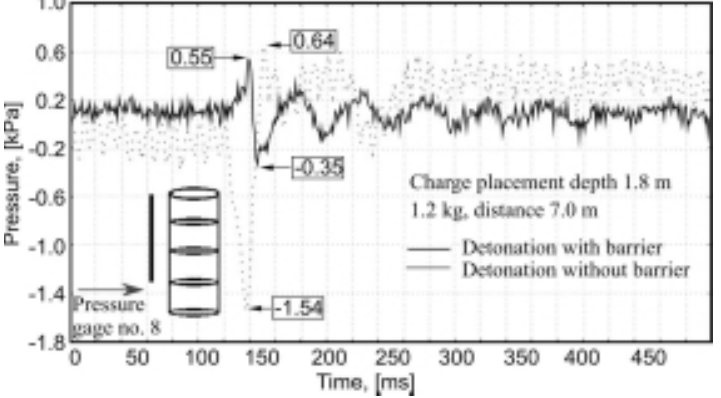
Fig. 20. Time histories of pressures p h on the structure front, measured by gage No. 8 from a detonation at 7.0 m from the silo.